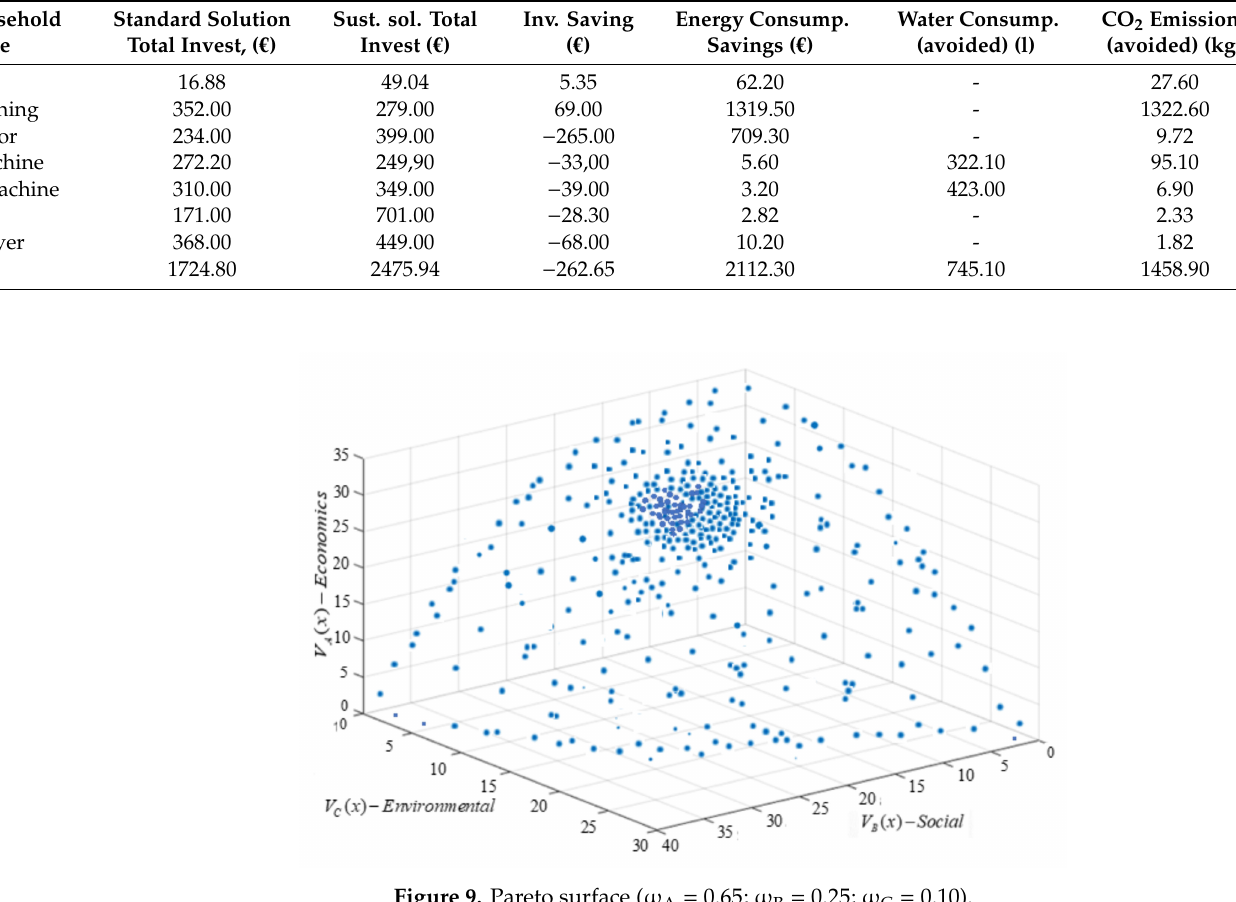
Figure 9. Pareto surface ( ω A = 0.65; ω B = 0.25; ω C =